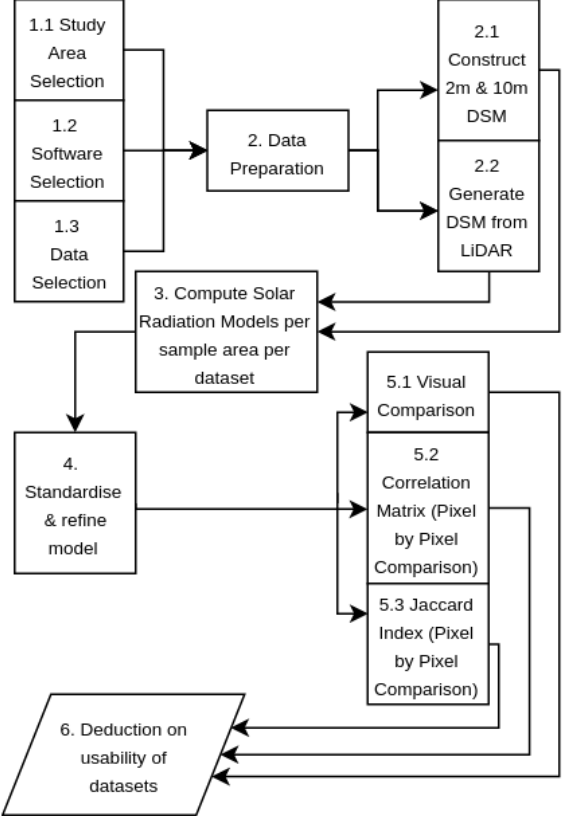
Figure 1. Evaluation process